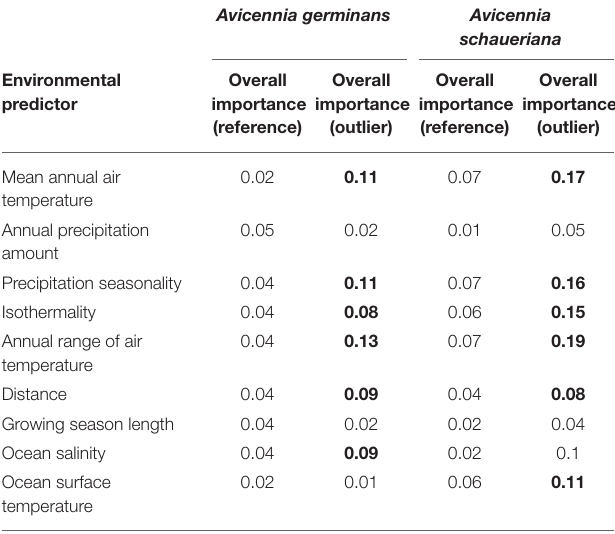
TABLE 2 | Overall importance of variables according to the impurity reduction measured by the Gini index (Breiman et al., 1984) for Avicennia germinans